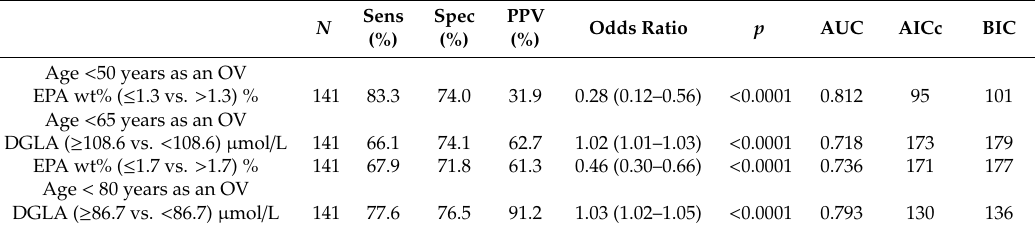
Table 5. Threshold values for the age at onset of ICH using receiver operating curves from logistic regression